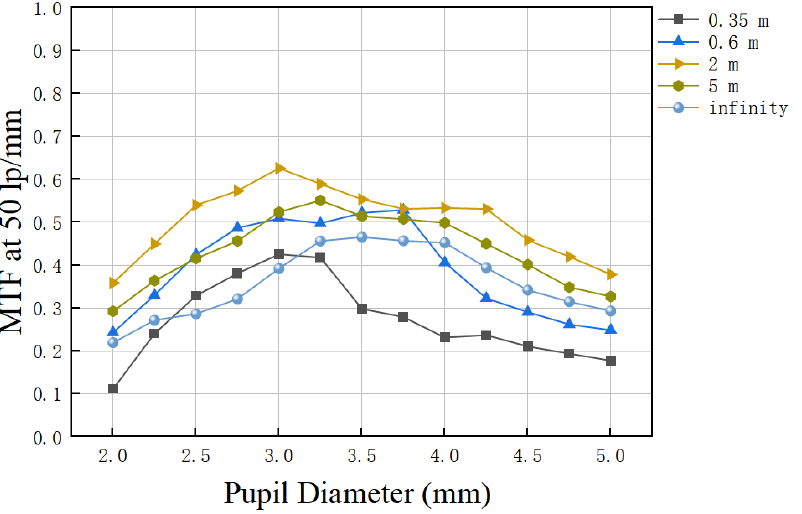
Figure 3. MTF at 50 lp/mm as a function of pupil diameter of the pseudophakic eye model for five object locations of 0.35, 0.6, 2, 5 m, and infinity. object locations of 0.35, 0.6, 2, 5 m, and